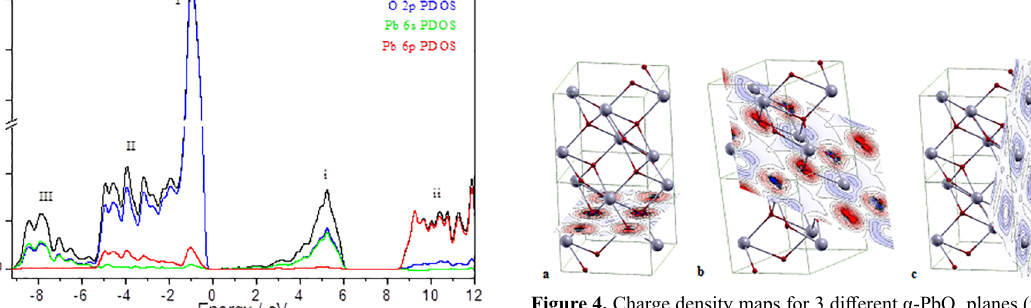
Figure 4. Charge density maps for 3 different α-PbO denotes an excess of negative charge and blue a deficiency of it). . a : oxygen only; b : oxygen and lead; c : lead 2